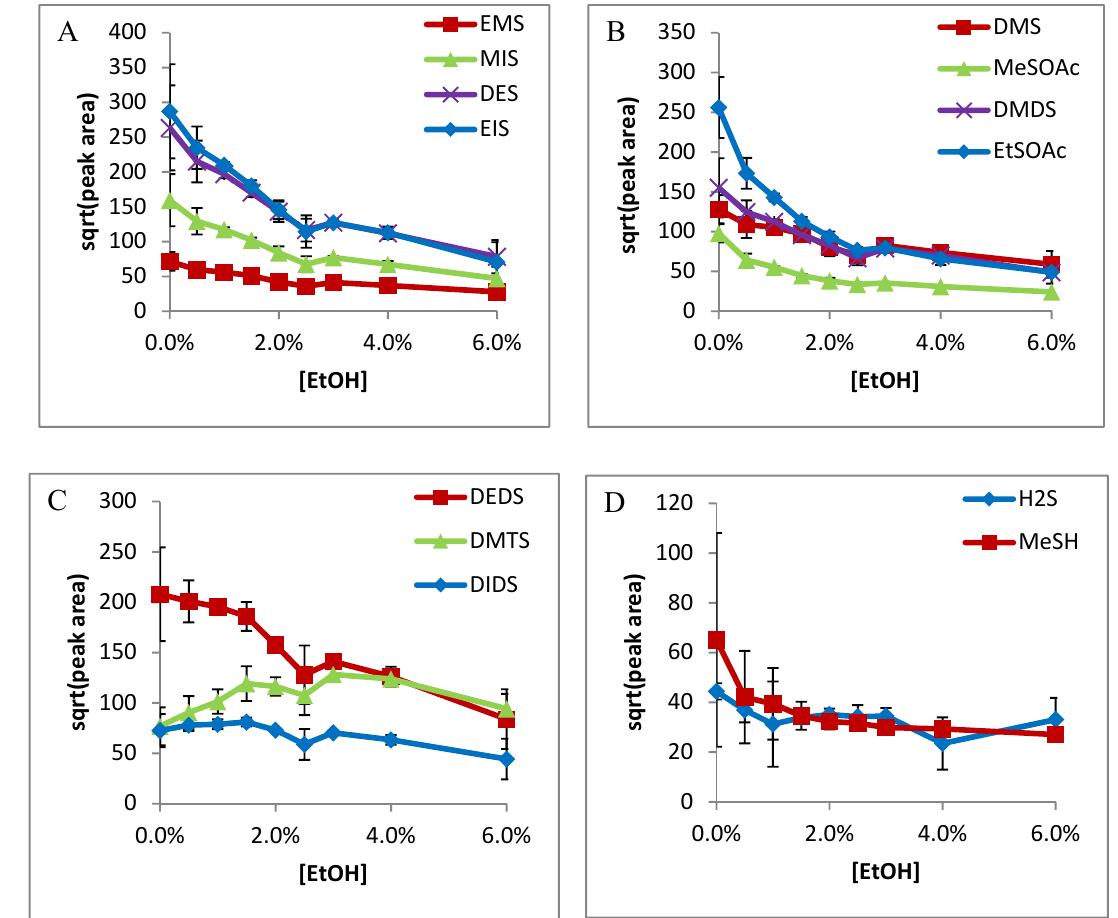
Figure 3. Effects of ethanol on the adsorption of DVB-PDMS SPME fiber of: A ) Internals standards EMS, MIS, DES, and EIS; B ) DMS, MeSOAc, DMDS, and EtSOAc; C ) large compounds DMTS, DEDS, and DIDS (IS); D ) highly-volatile compounds MeSH and H 2 S.